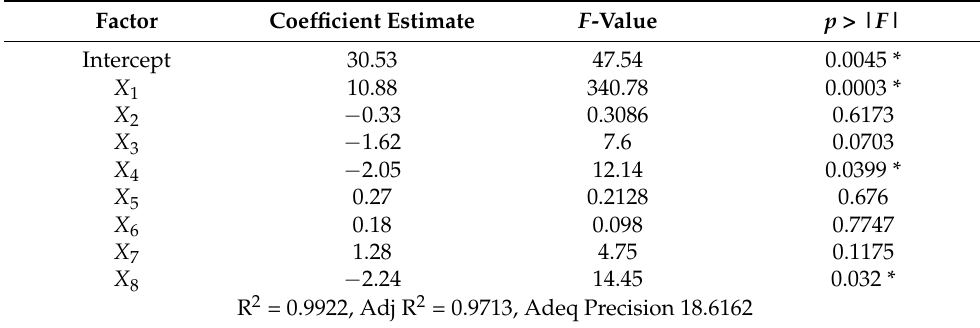
Table 4. ANOVA analysis for the Plackett–Burman factorial model of the yield of M-EPS. Factor Coefficient Estimate F -Value p > | F | Intercept 30.53 47.54 0.0045 * X 1 10.88 340.78 0.0003 * −